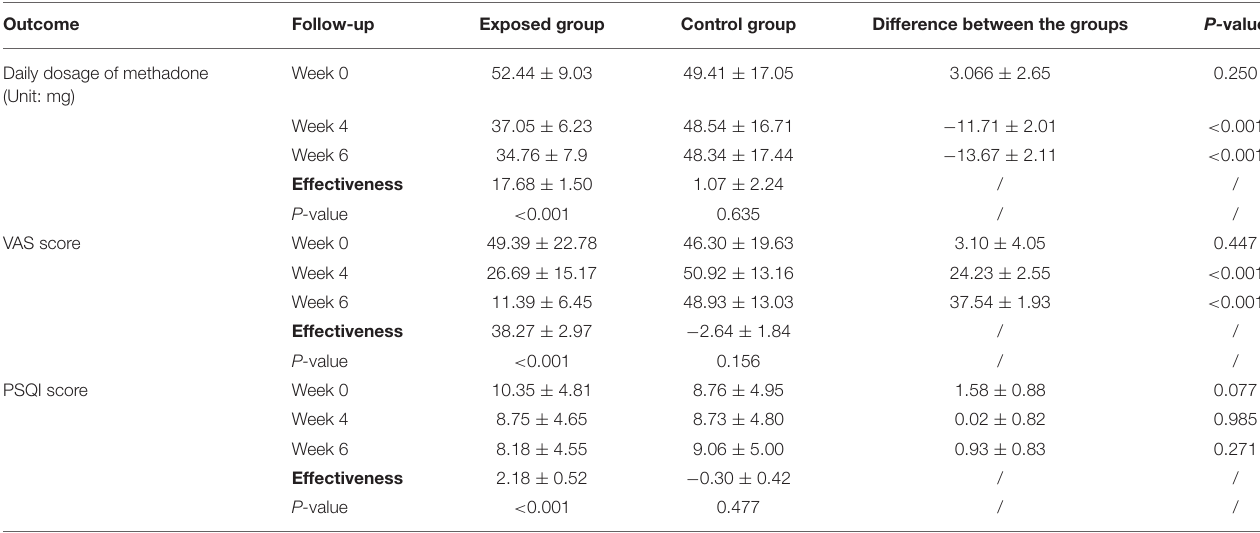
TABLE 3 | Outcome comparison of the exposed group and control group (X ±